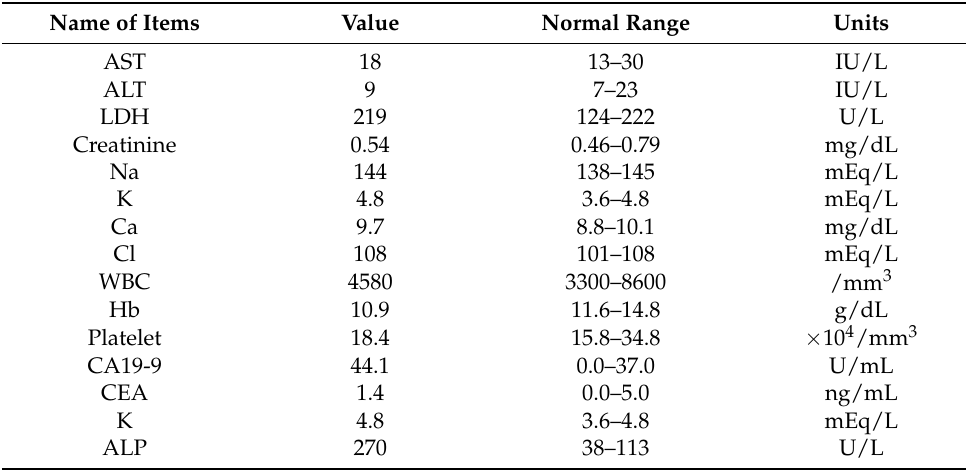
Table 1. Results of laboratory tests conducted prior to treatment initiation.